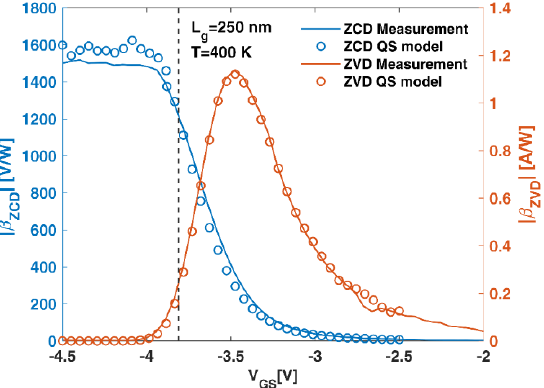
Figure 3. Measurements of the responsivity (lines) in ZCD and ZVD at T = 400 K for the device with 𝐿 𝑔 = 250 nm compared with the values provided by the quasi-static model (symbols). The dotted vertical line represents the threshold voltage.